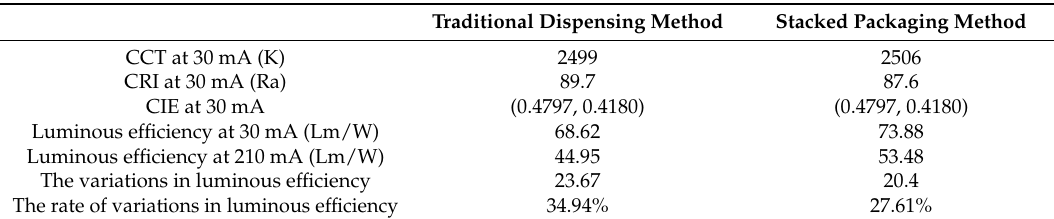
Table 1. Electroluminescence data of traditional dispensing packaged filament and stacked-type packaged filament.